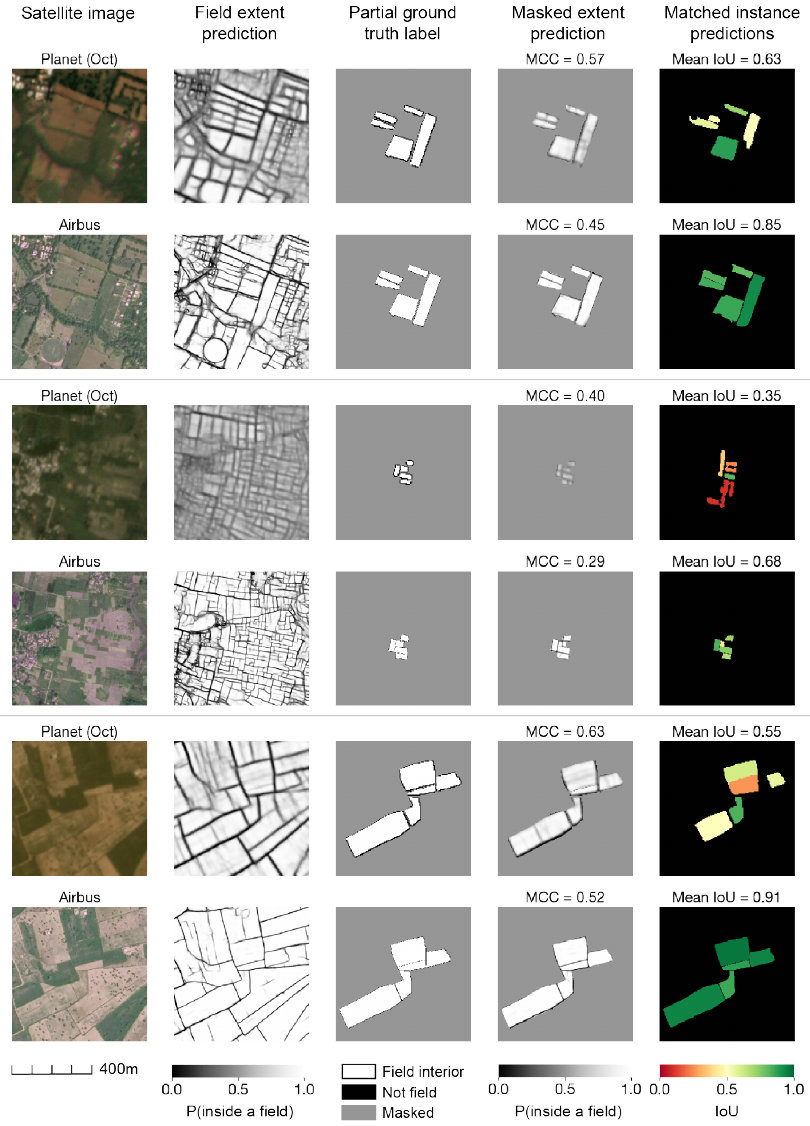
Figure A8. Three example locations where Planet-based predictions have simultaneously higher MCC and lower IoU than Airbus SPOT-based predictions. This illustrates that MCC is difficult to interpret across datasets with imagery of different resolutions and should be reserved for comparing experiments on the same